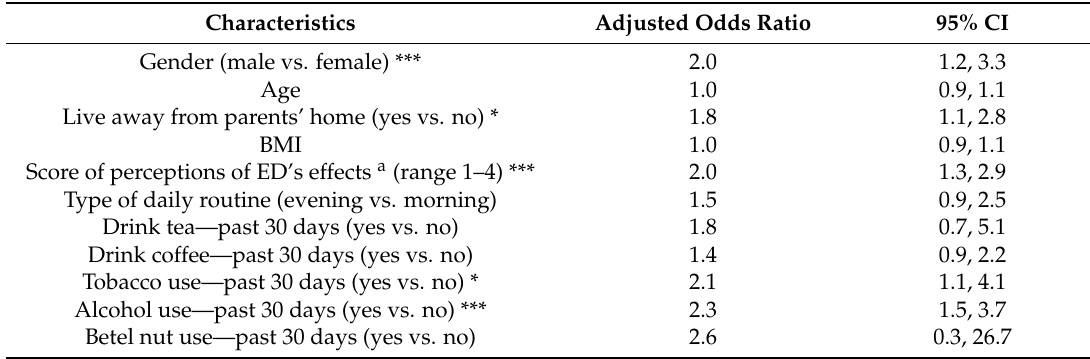
Table 4. Predictors of energy drink consumption in past 30